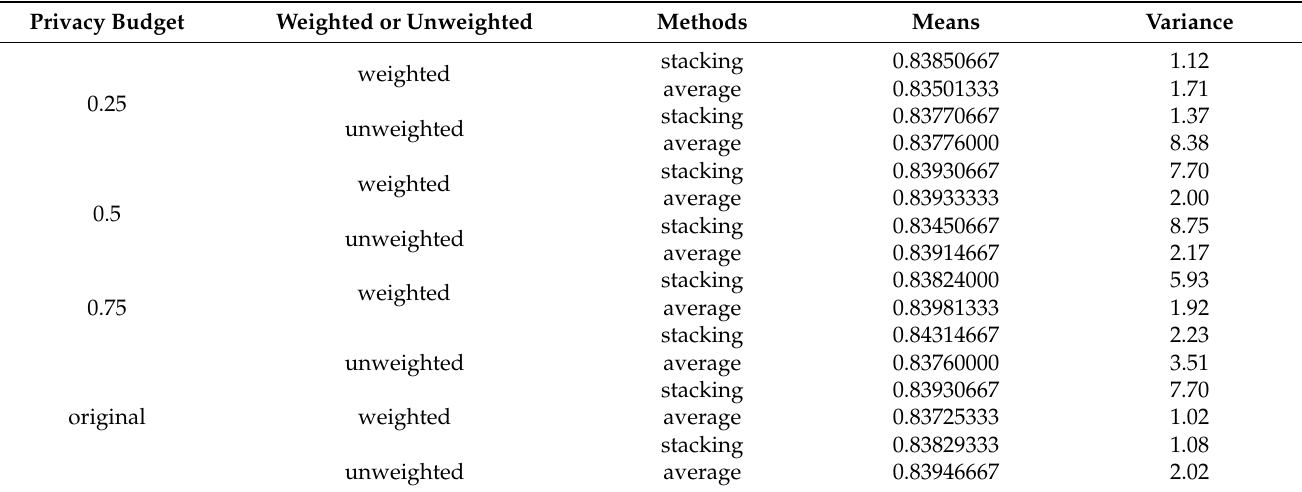
Table 11. The change table of updated global model h 4 was calculated by different methods in t 4